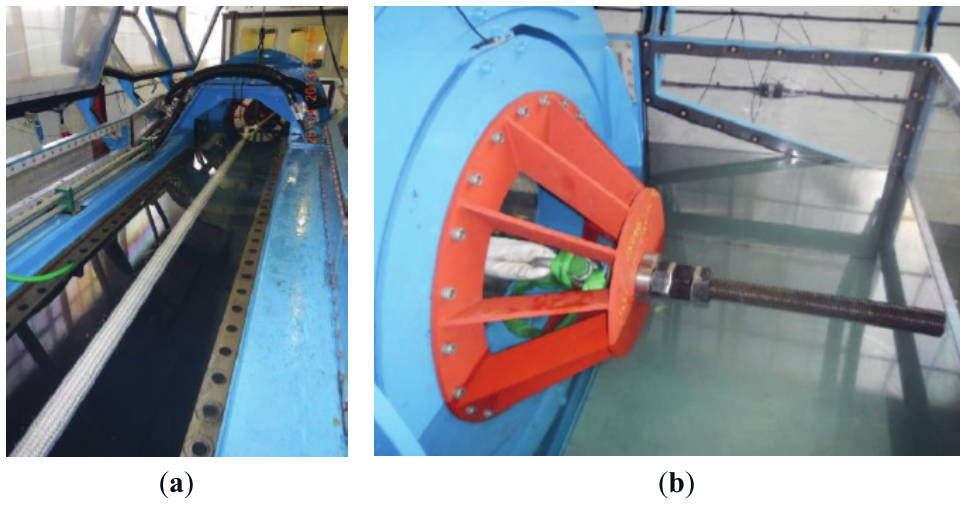
Figure 4. ( a ) DMaC with a tether fitted and full of water; and ( b ) the pre-tension adjuster and “top hat”.